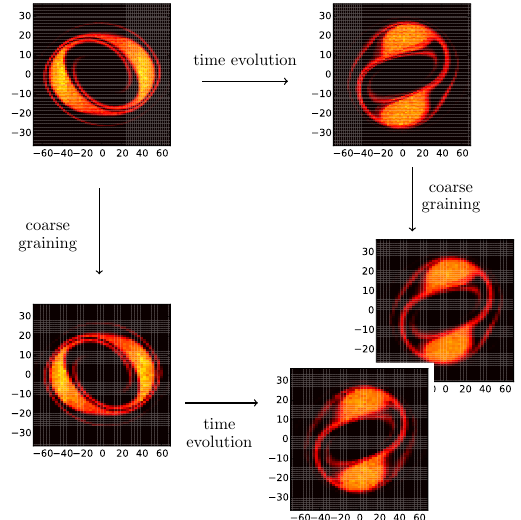
Figure 5: Diagram illustrating the fact that coarse-graining commutes with GHD time evolution. Starting from the state at t = 8 τ in the anharmonic case (same data as in Fig. 2 in the main text), we first coarse-grain the system (i.e. we chose larger ( θ , x ) in our molecular simulator bins, and re-sample the phase-space distribution ρ p accordingly) and let it evolve during a time ∆ t = 2 τ . We compare the resulting distribution with the one obtained from evolving the system first, and then coarse- graining it. The two resulting distribution are almost